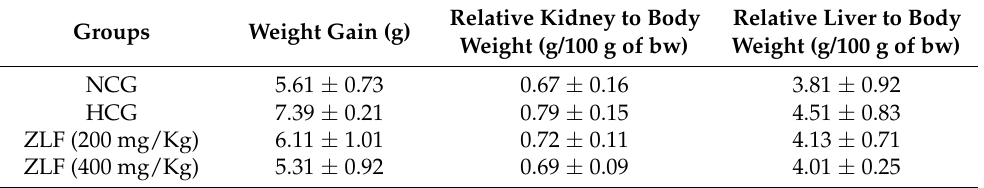
Table 1. Bodyweight and Relative Weight of Organs. Groups Weight Gain (g)